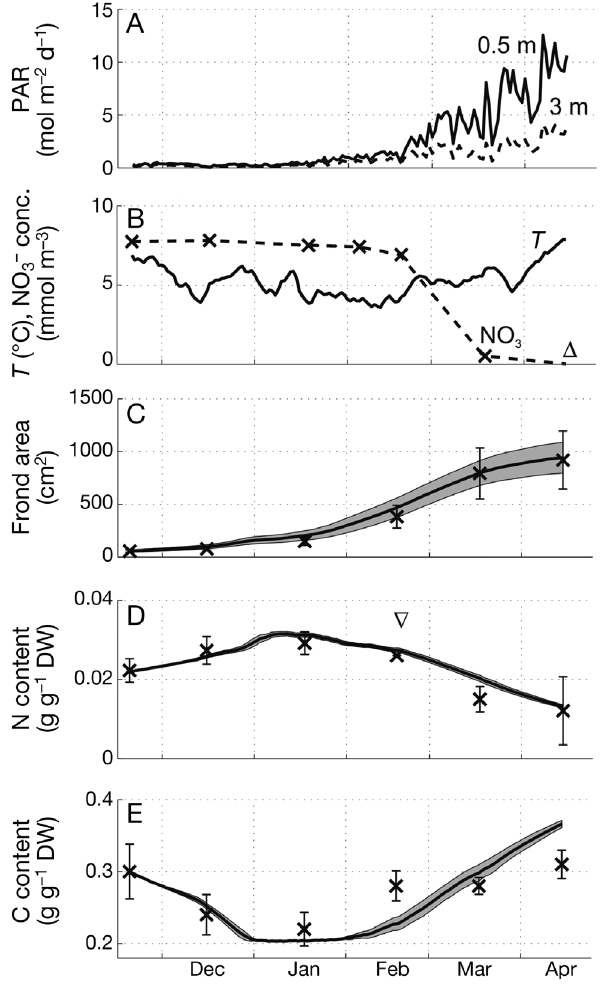
Fig. 4. Data from the mesocosm basin growth experiment and corresponding model simulations (see Table 2). (A) To- tal daily photosynthetically active radiation (PAR) at 0.5 and 3 m depths. (B) Temperature (T , daily average values, con- tinuous line) and integrated (0 to 3 m) NO 3– concentration (crosses, dashed line). The Δ in April indicates a value (0) not actually recorded, but used in the simulations. Average measured (n = 6 [except ∇ , n = 1], crosses) and simulated (n = 6, continuous lines) values for (C) frond area and for (D) nitrogen and (E) carbon content of Saccharina latissima sporophytes. Error bars indicate sample mean standard de- viations of the measurements, while shaded grey regions are sample mean standard deviations for the